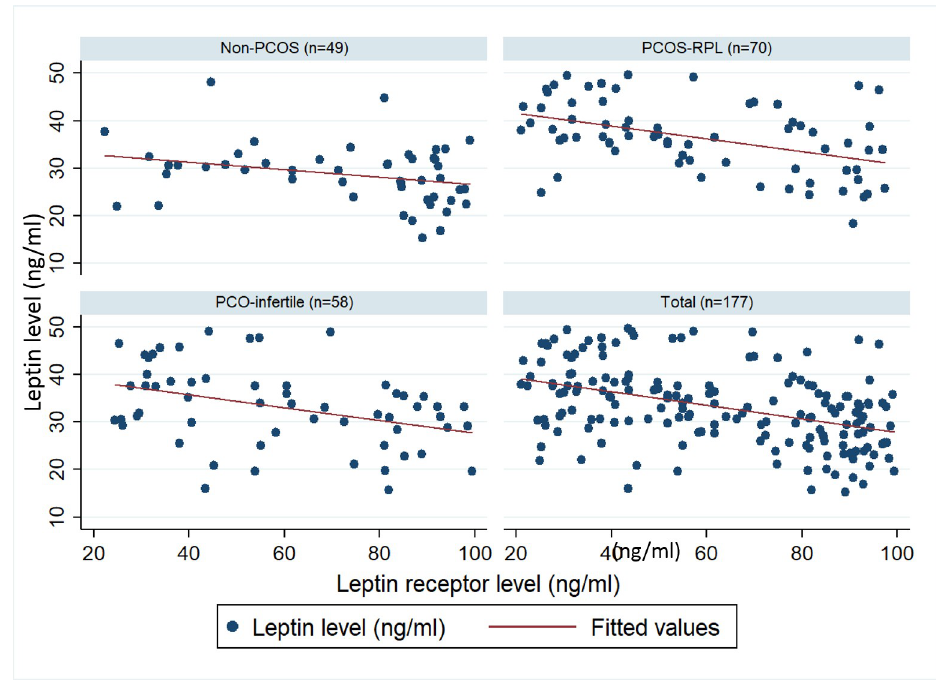
Fig 2. Comparison of correlation between leptin and leptin receptor levels in non-PCOS subjects and PCOS- infertile or PCOS-RPL groups, as well as all population.